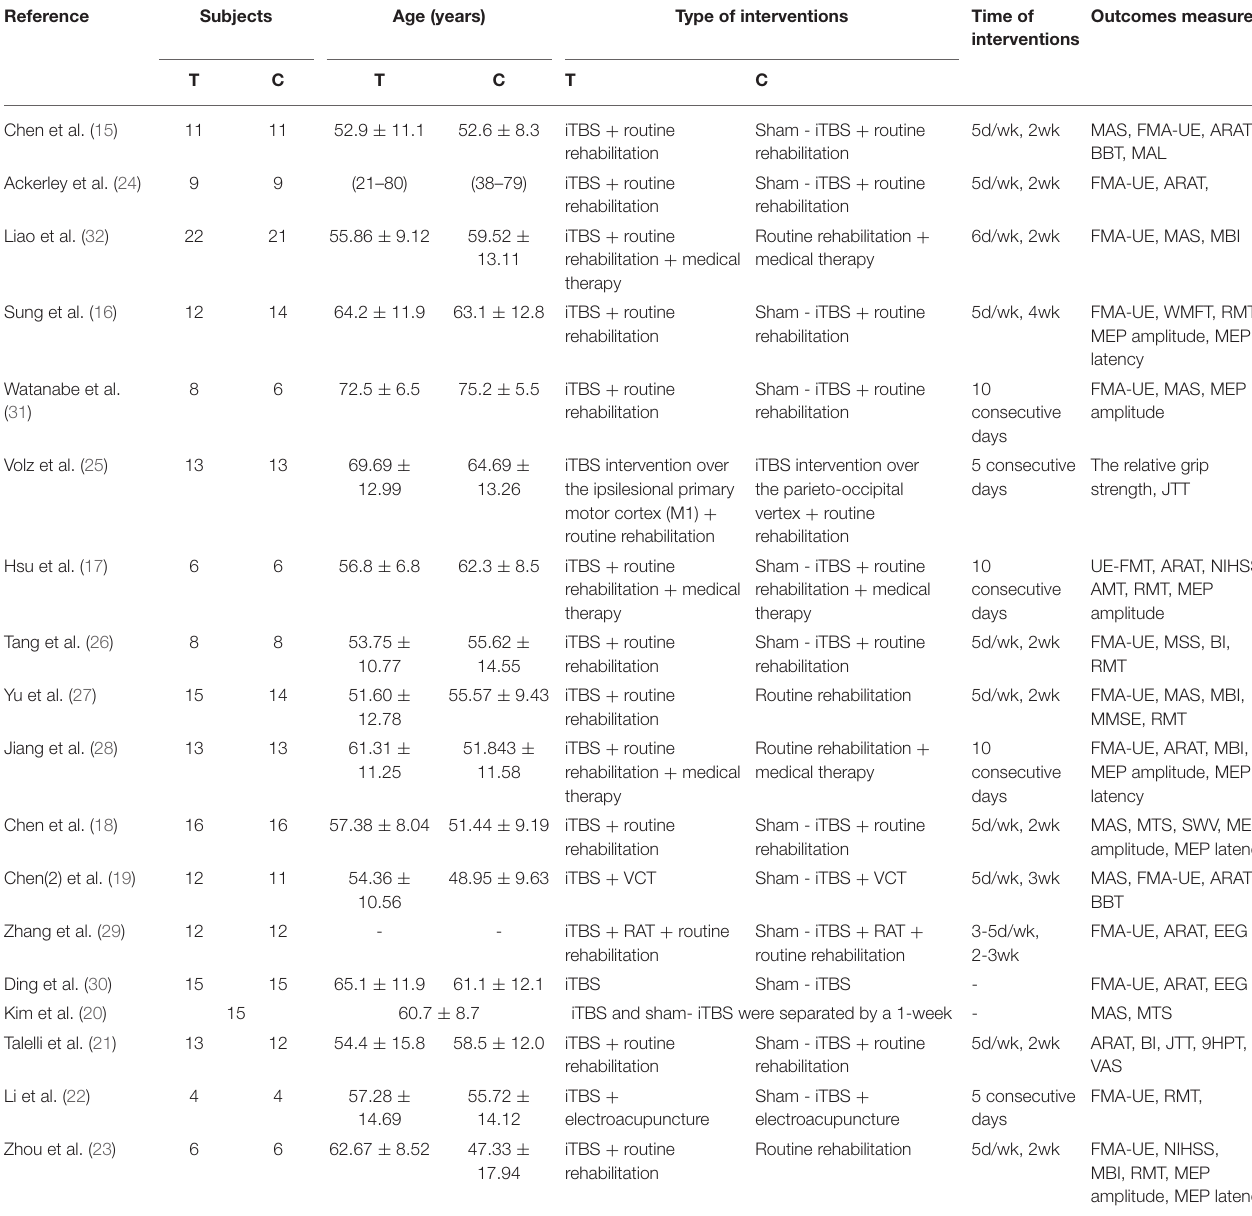
TABLE 1 | Summary of the included studies and the detail of intervention and measurement.